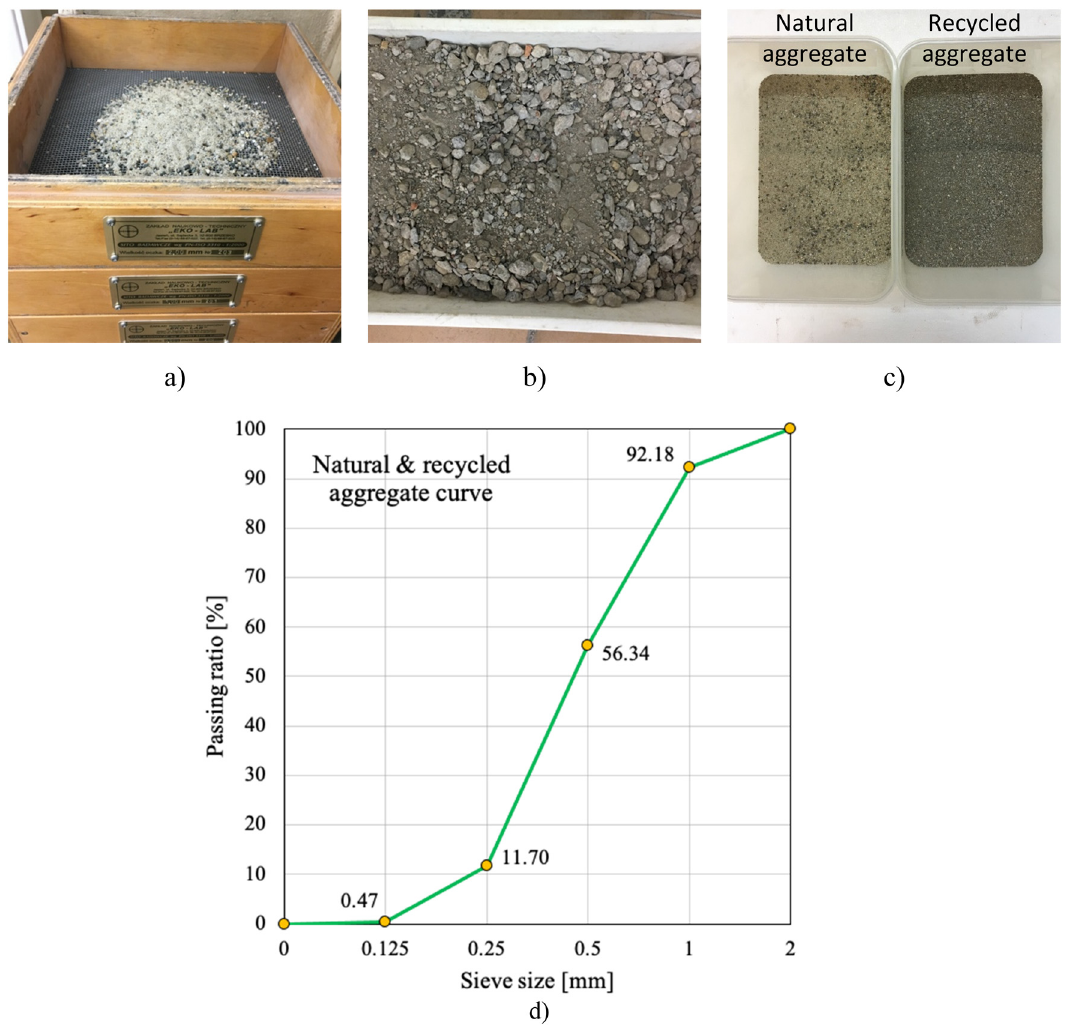
Figure 4: The aggregate preparation process: ( a ) sieve process of the natural aggregate; ( b ) the recycled aggregate before the sieve process; ( c ) the view of the two types of aggregates; ( d ) the aggregate grain size distribution.